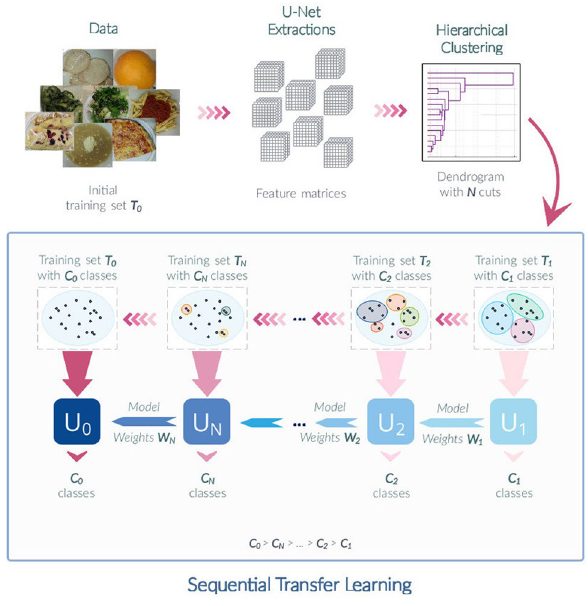
Figure 2. Proposed method. Pipeline of proposed network training method—Sequential Transfer Learning (STL) based on Hierarchical Clustering